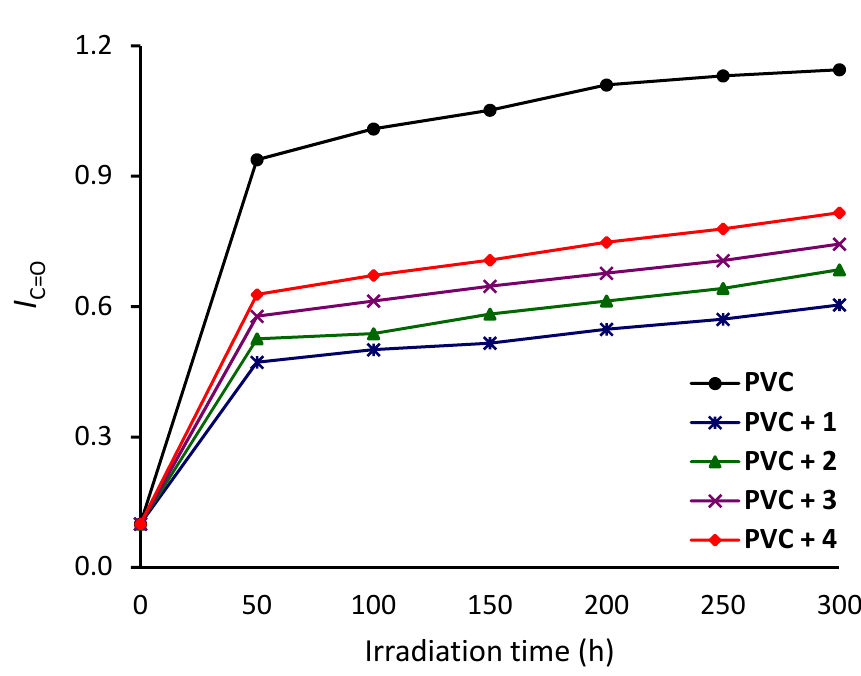
Figure 3. The I C=O of the PVC films versus time.